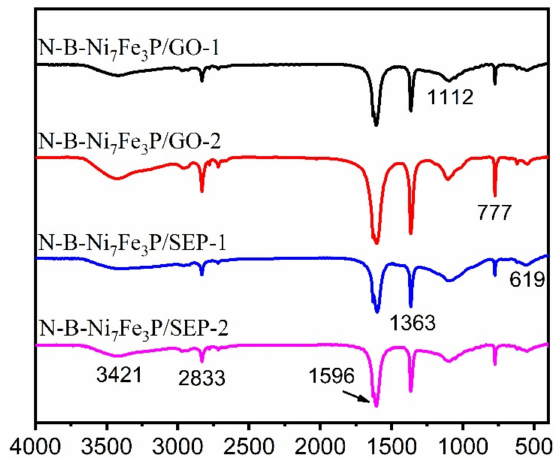
Figure 1. FT-IR spectra of N-B-Ni 7 Fe 3 P/SEP and N-B-Ni 7 Fe 3 P/GO. The morphology and microstructure information of N-B-Ni 7 Fe 3 P/SEP and